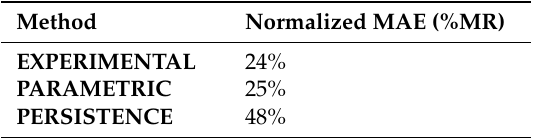
Combination of WIRE data and WRF ARW model version 2.2.1 using initial and boundary conditions from NCEP GFS + Gaussian Generalized Linear Model (Catania) Table 8. Mean normalized MAE (%MR) for the methods reported in Table 4 applied to Portici